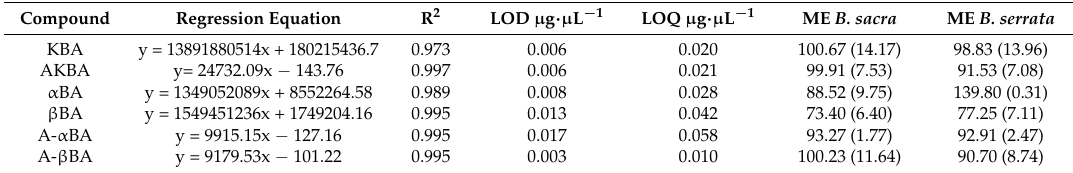
Table 3. Validation of boswellic acids (BAs) quantitative analyses of methanolic extracts from B. sacra and B. serrata . (Standard